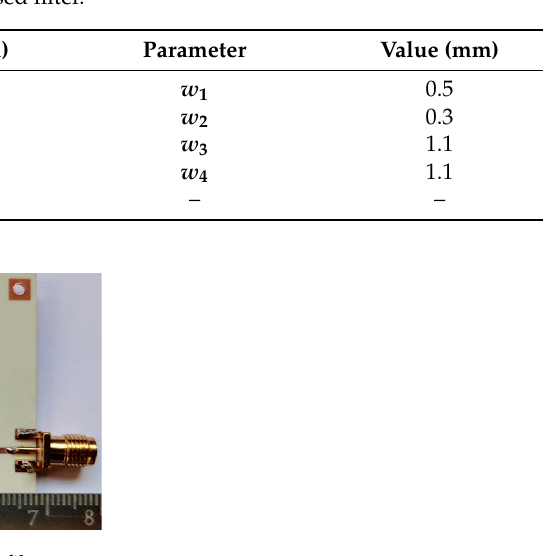
Figure 6. Extracted Q e versus f C with different s .